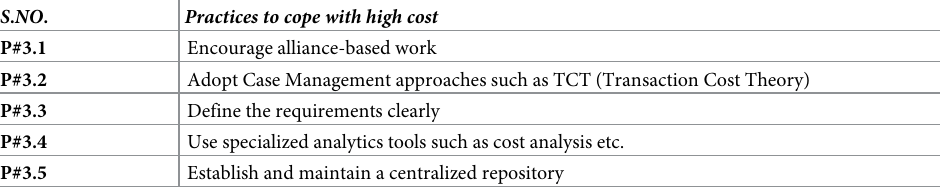
Table 6. Practices to cope with high cost in COR.